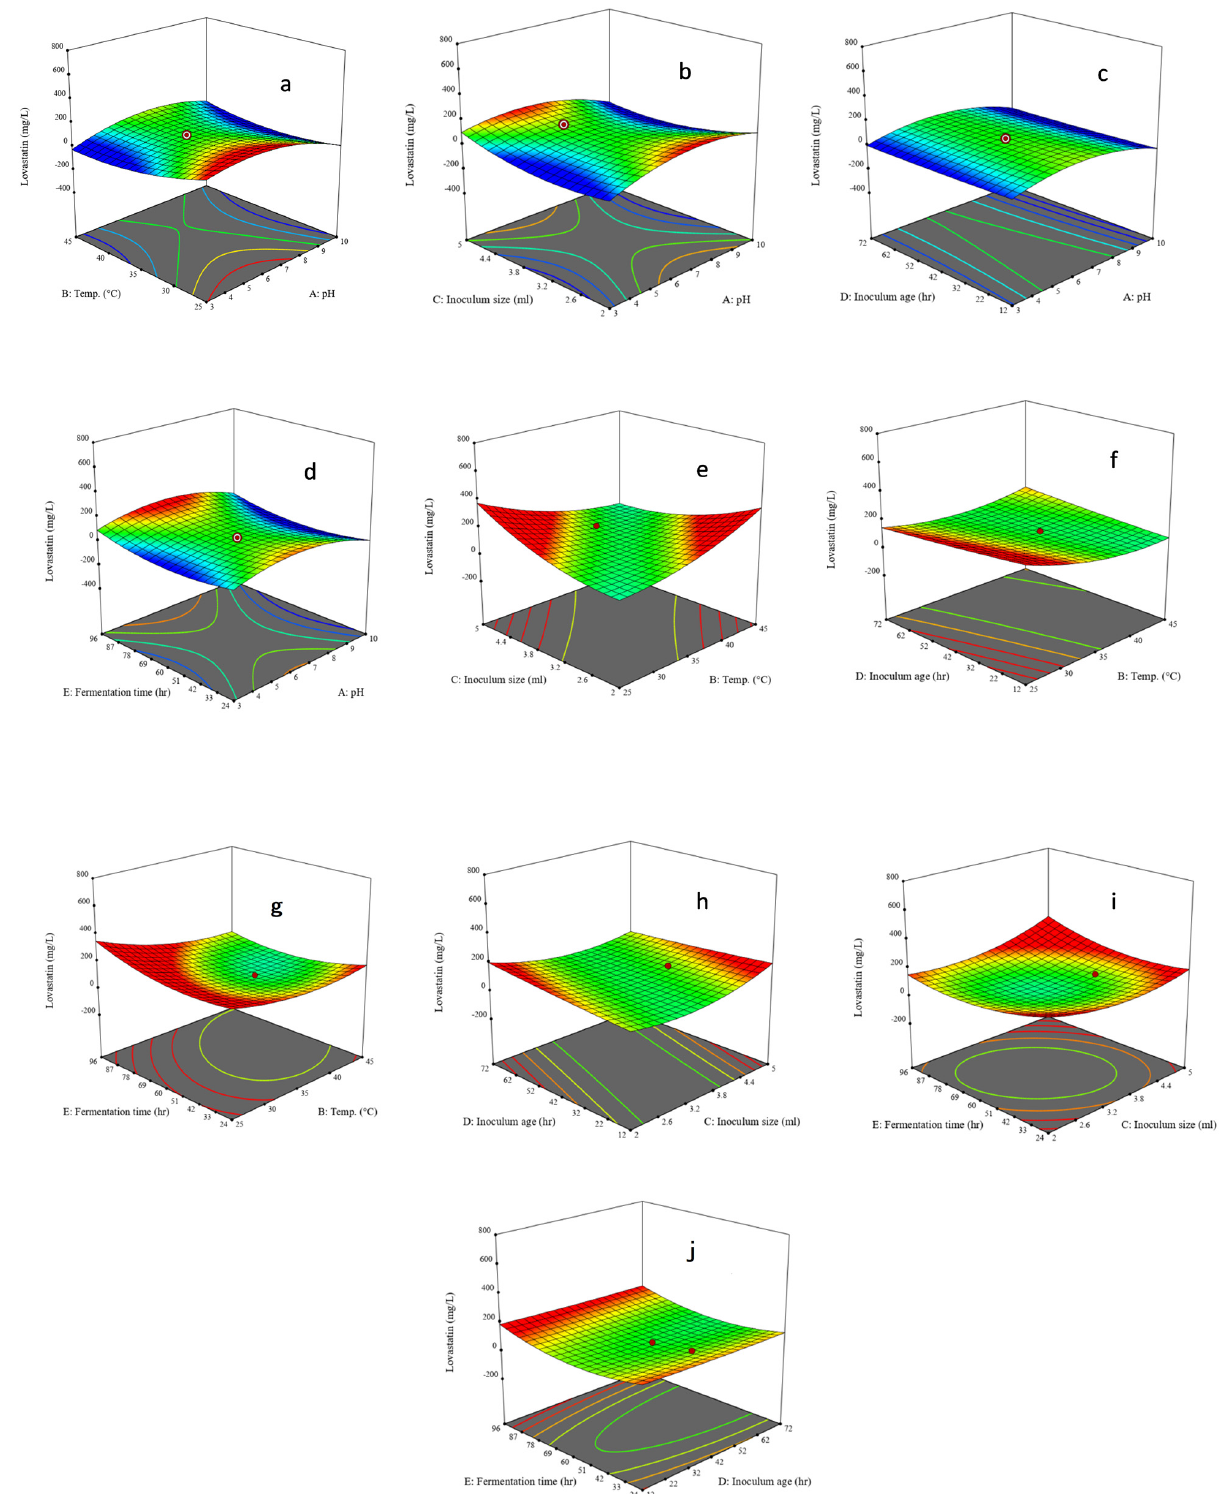
Figure 2. Three Dimensional plots show the effect of ( a ) factor AB ( b ) factor AC ( c ) factor AD ( d ) factor AE ( e ) factor BC ( f ) factor BD ( g ) factor BE ( h ) factor CD ( i ) factor CE ( j ) factor DE of various fermentation parameters for optimization and factors to factor inter-relationship for the synthesis of lovastatin through Aspergillus terreus ATE-120 by SSF.